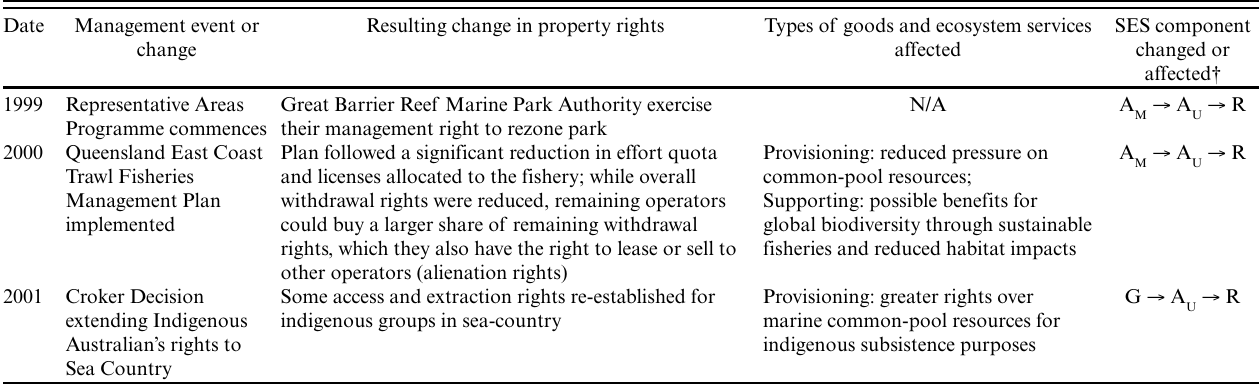
Table 3. Major management changes through time for the Great Barrier Reef Marine Park, and resulting property rights changes: transition period,